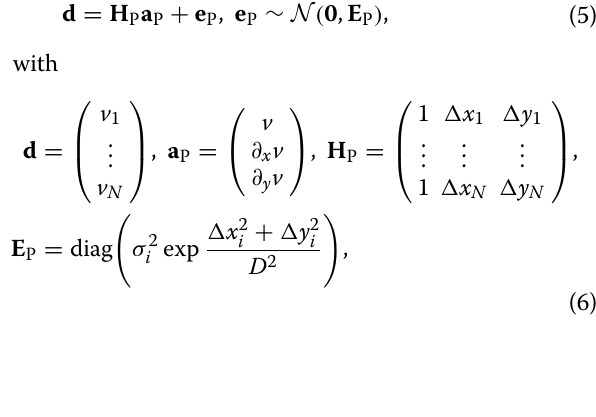
N where the notation represents the Gaussian 2 distribution with mean m and variance σ . Equation (4) means that data at remote points from P do not contribute to the estimation at P . D is the distance decaying constant (DDC), which is a hyperparameter in this analysis and controls the spatial range of significance. Since the weight of each station varies continuously, this method leads to a smooth estimation of velocity and strain-rate fields. The observation Eq. (3) is expressed in a matrix form as